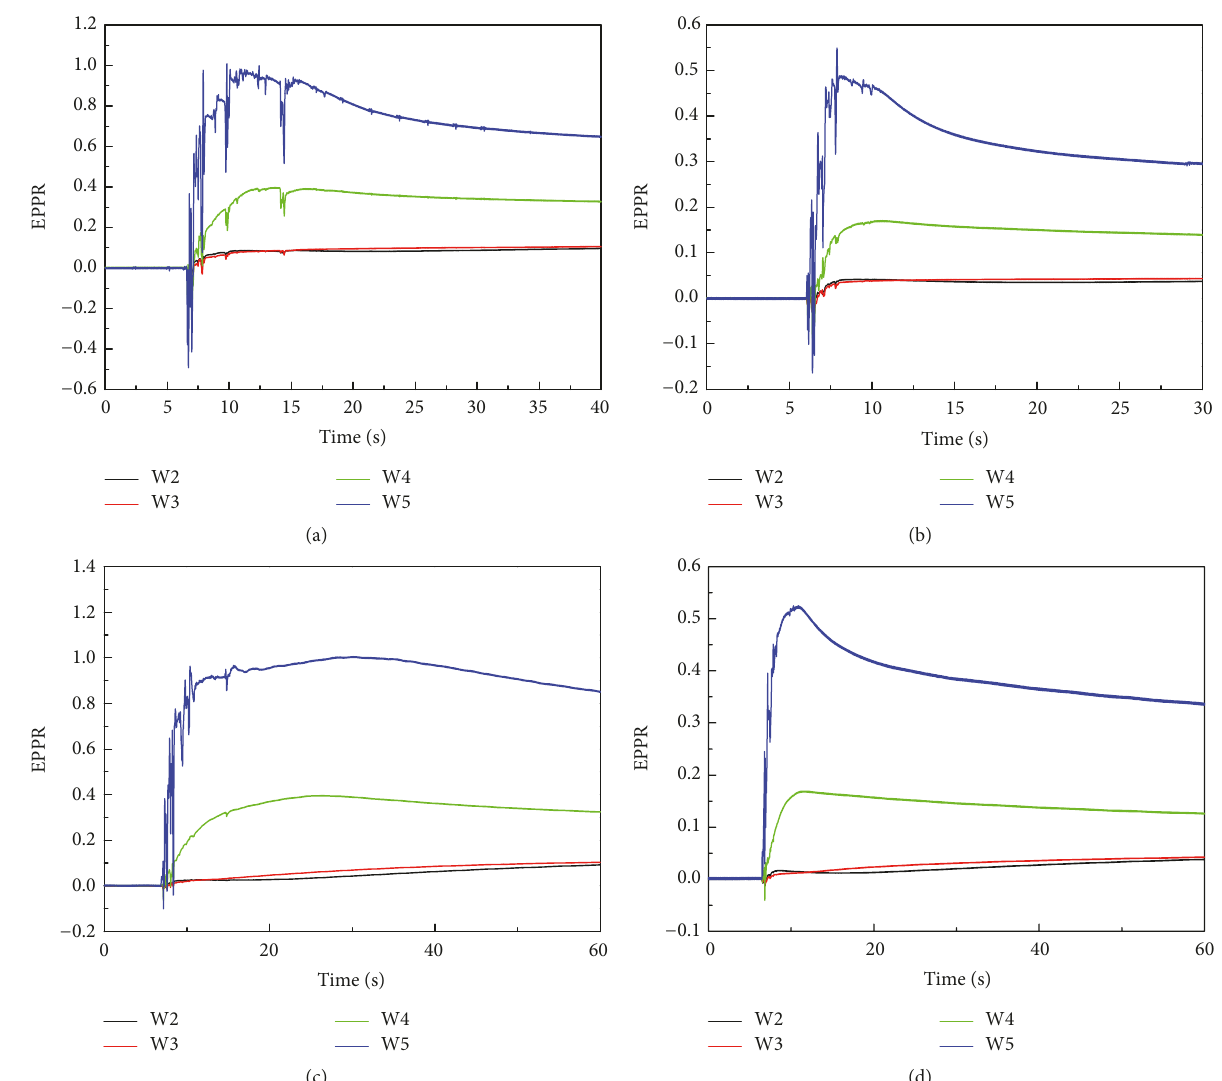
Figure 11: EPPR under (a) excitation MW-3 and (b) excitation KB-3 during test 2 and under (c) excitation MW-3 and (d) excitation KB-3 during test